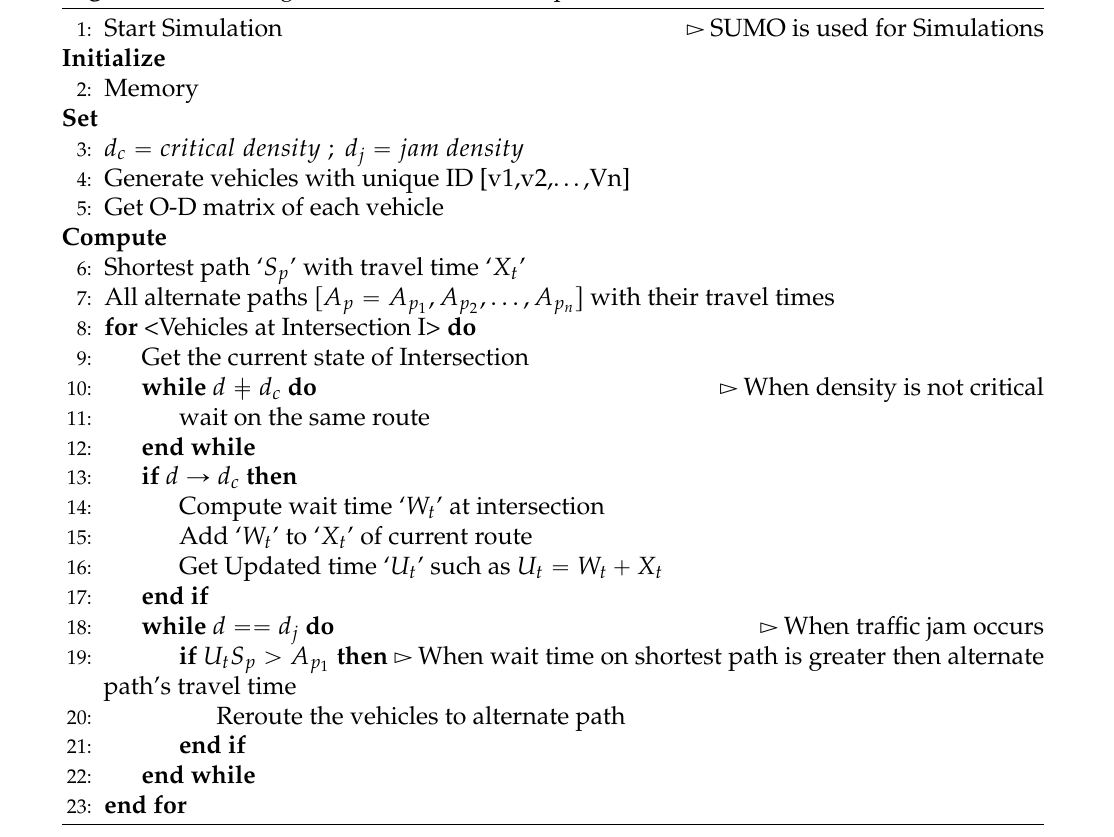
Algorithm 3 Routing of vehicles to alternate